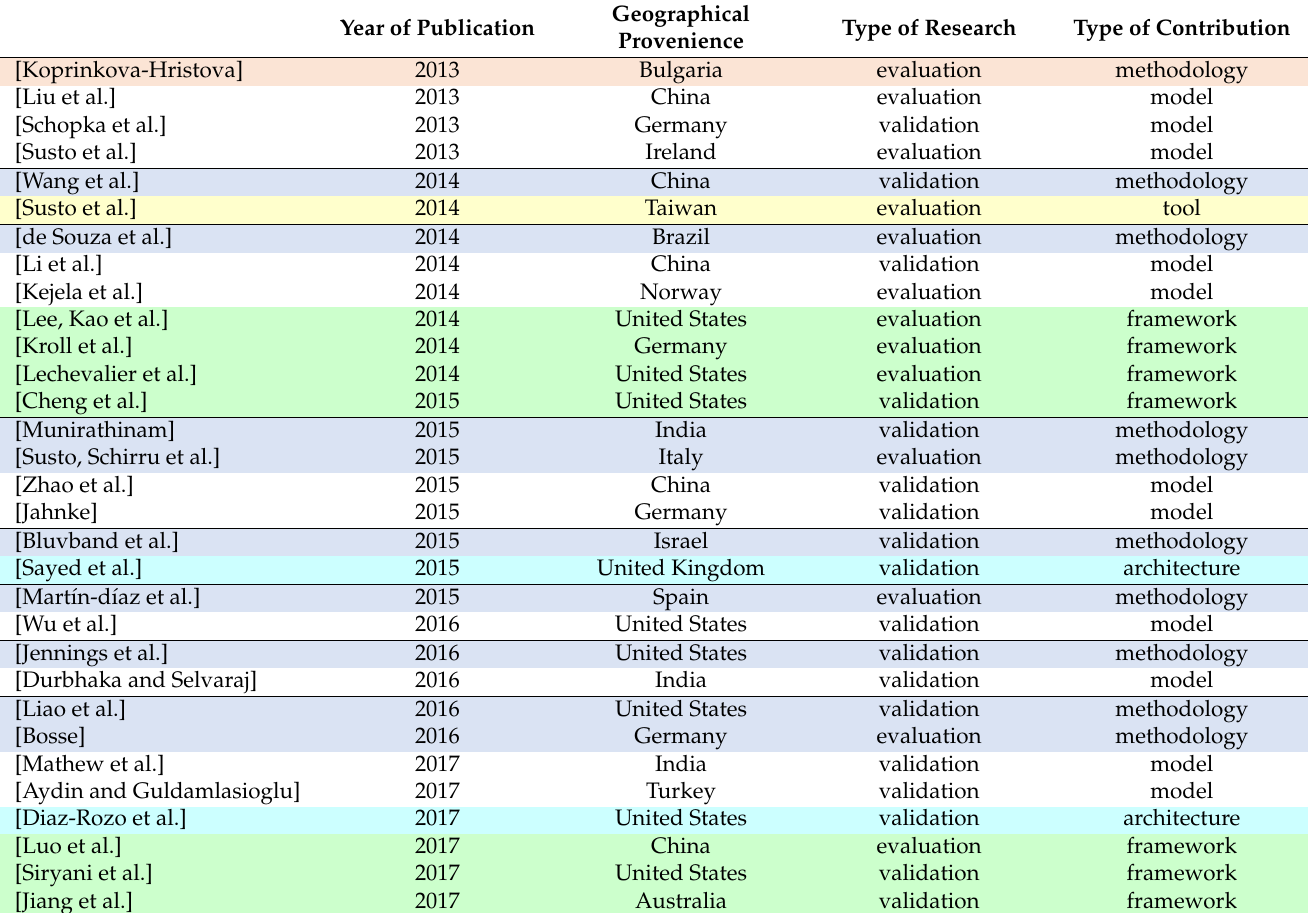
Table A1. Table of referenced papers clusterized per year (basing on principal author geographical provenience), Type of research and Type of